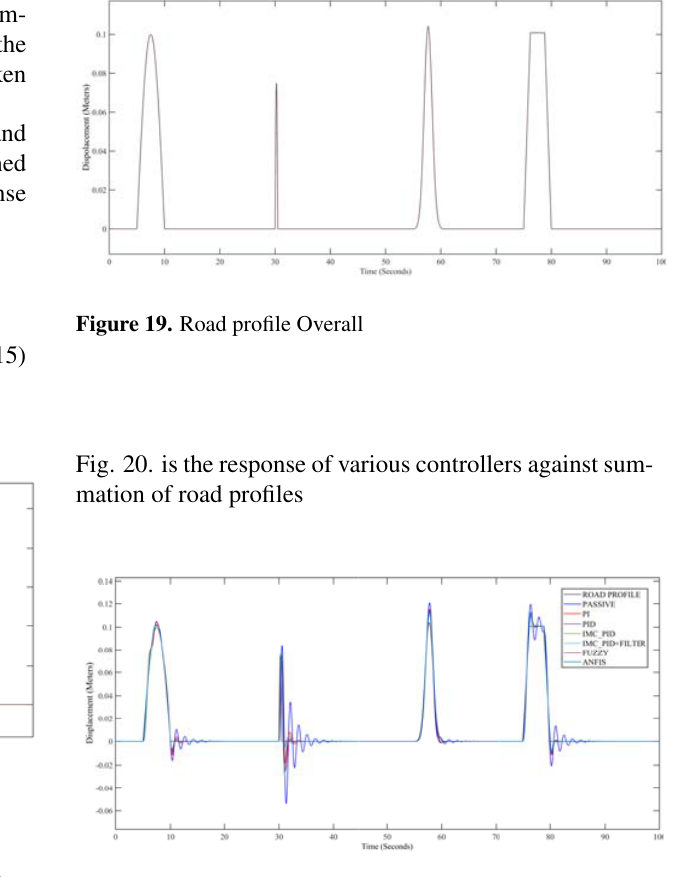
Figure 20. Response against Overall Road